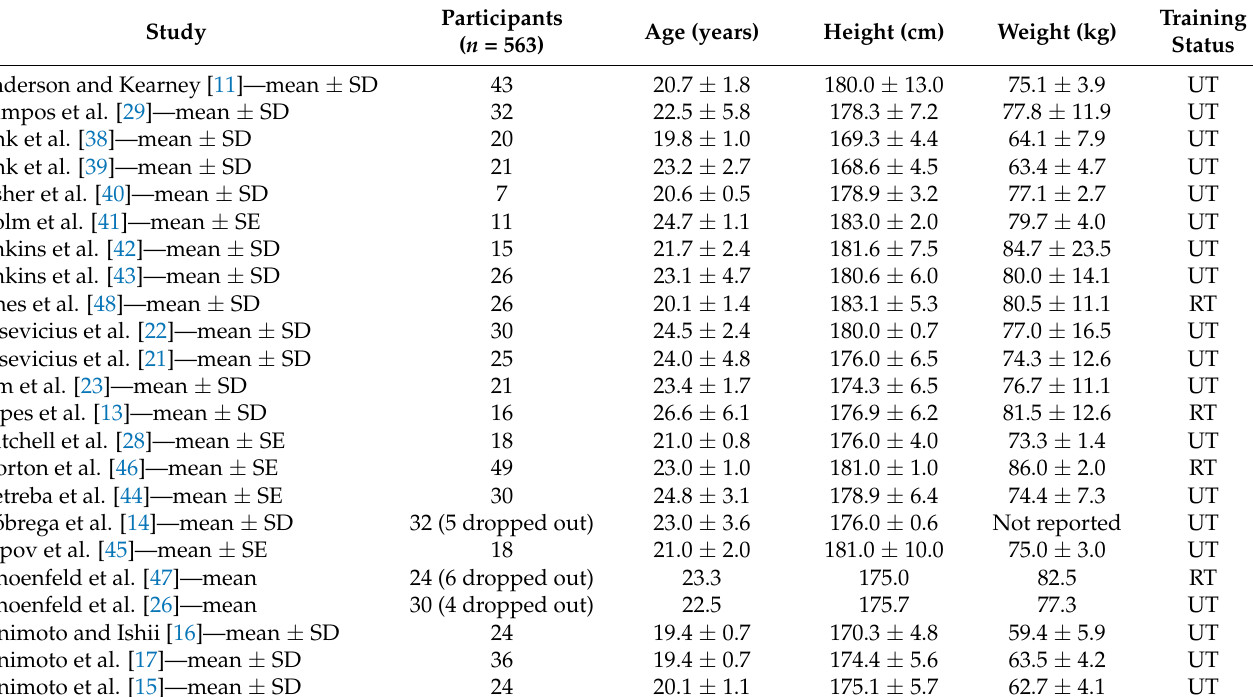
Table 2. Characteristics of the